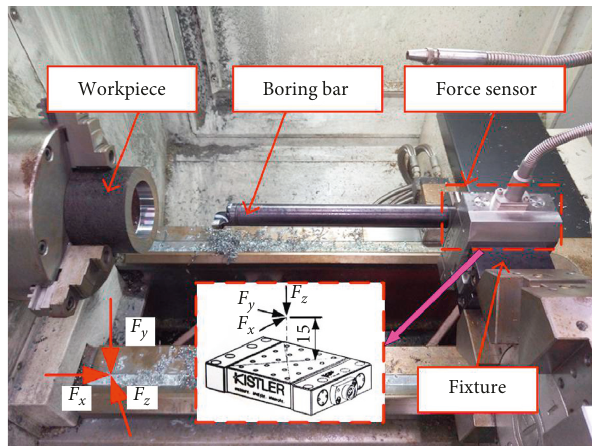
Figure 16: Boring experiment.